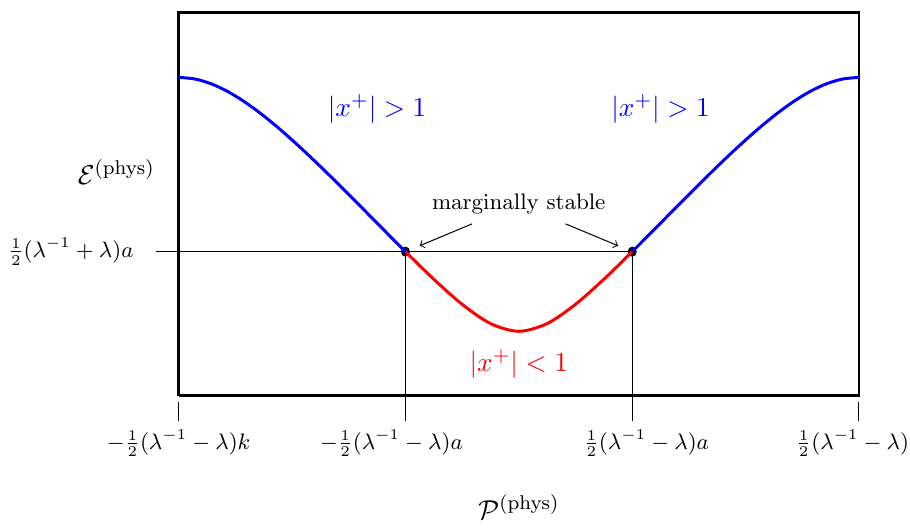
Figure 2 . The solution of the dispersion relation for the bound state labeled by a gives the energy as a function of the momentum. The momentum is only valued in the (cid:12)nite region as indicated. The soliton (red) and magnon branches (blue) are shown. In the sigma model limit, (cid:21) ! 1 ( k ! 1 ) and the soliton branch disappears. In the opposite limit (cid:21) ! 0, the magnon branch disappears. The magnon and soliton branches are on disconnected sheets of the S-matrix rapidity torus. However, the energy and momentum \touch" at points of marginal